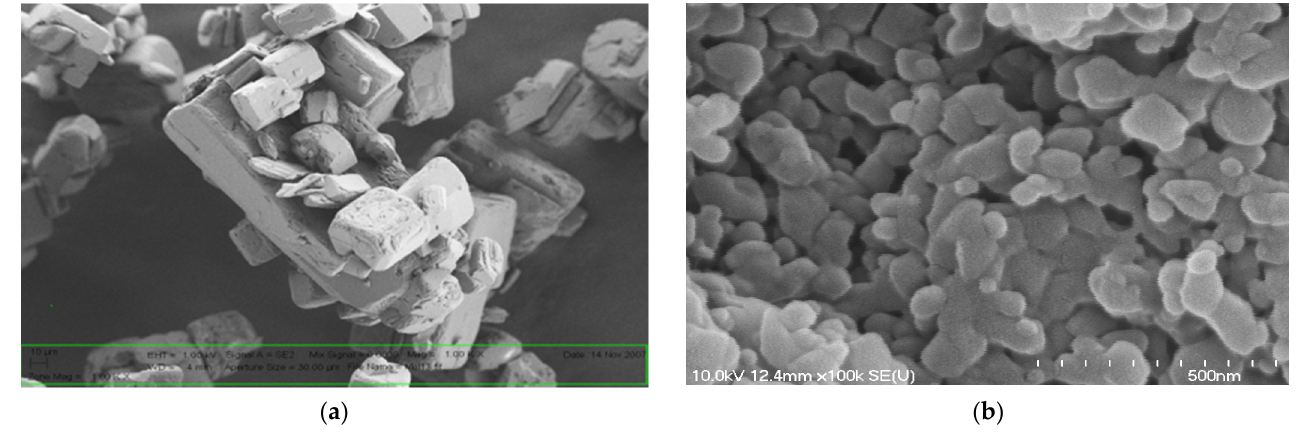
Figure 3. The SEM images of raw MX ( a ) and nanoMX powder ( b ).